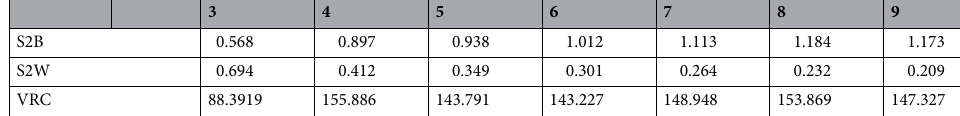
show the percentages of boys and girls classified according to the World Health Organization’s well-being spectra. This figure illustrates the differences in well-being scores between boys and girls, particularly in the group at risk of developing clinical symptoms of depression and the group reporting high well-being. The first result of the QTA concerned the words most frequently used by the cohort of adolescents to describe the moments, situations, or events that help them feel good during the COVID-19 syndemic. Given that fre- quently occurring words reflect recurring themes in a textual corpus and serve as the foundation for more (38), sport (18), music (18), boyfriend (16), to play (15), time (15), to meet (10), to chat (9), to watch (8), to listen (8), home (7), to help (7), people (6), on-line (5), to sleep (5) and alcohol (4). Even this initial look at the